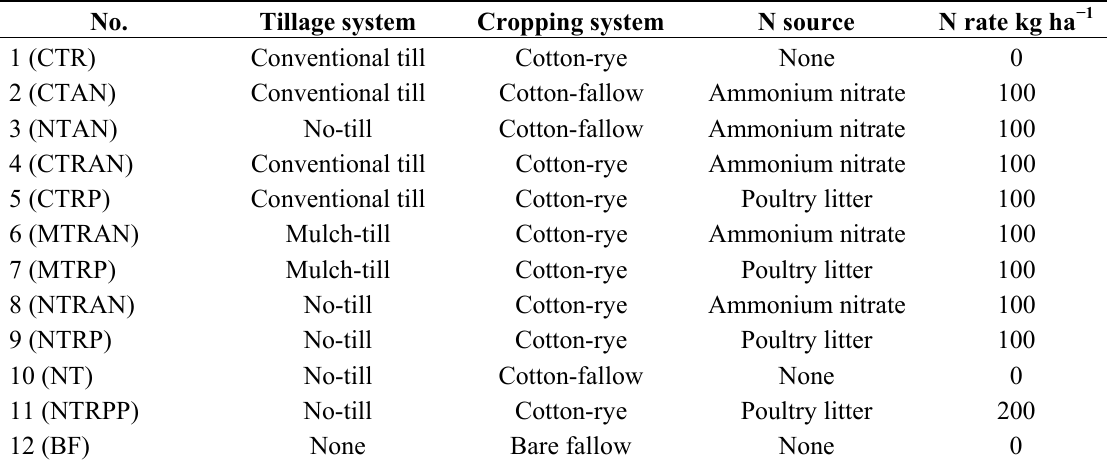
Table 1. List of treatments used in the cotton field, Belle Mina, AL, USA. No. Tillage